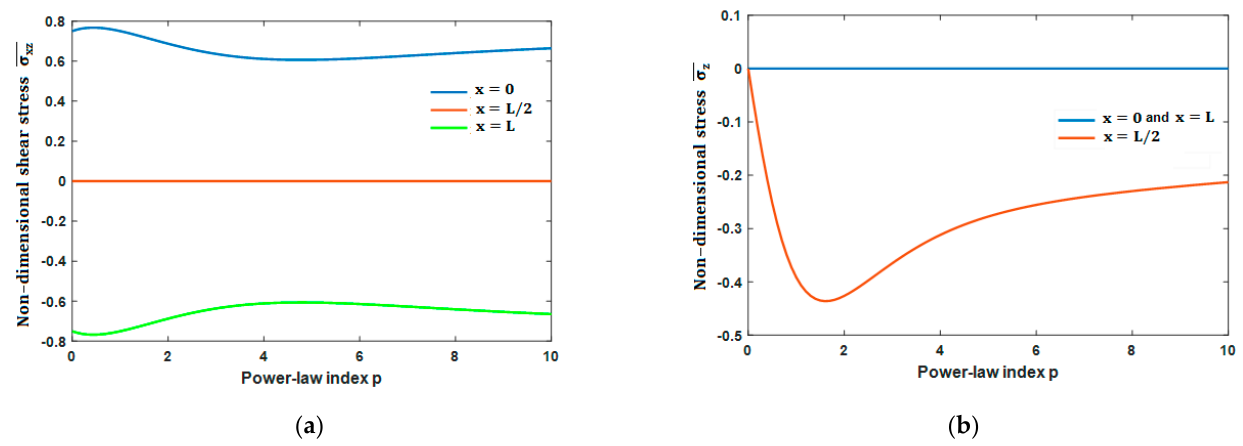
Figure 8. Non-dimensional: ( a ) Shear stress σ xz , ( b ) stress due to the thickness stretching σ z versus the material parameter. Variations of the non-dimensional axial stress σ x across the depth and versus non- dimensional length of the FGB are presented in Figure 9a,b for ( L / h = 5) and ( p = 5). The axial stress is zero at the end edges, but it is maximum at the middle of the beam, and the upper beam face is stretched. On the other hand, the lower face is compressed. Extension stress at the upper beam face is higher than the compressive stress at the lower face because at the upper face, the beam is ceramic-rich, whereas, at the lower face, it is metal-rich. It is observed that the neutral plan with zero axial stress is moved upwards relative to the middle position. This is due to the non-homogeneous material of the FG beam ( p = 5). Figure 10a,b plots the distributions of the non-dimensional shear stress σ xz through thethickness and versus the non-dimensional length of the FG beam, respectively, for ( L / h = 5) and ( p = 5). These figures reveal that the shear stress reaches its maximum value at the beam ends but with opposite signs. It is cancelled in the middle of the beam on the neutral plane and the lower and upper faces. As a result, the conditions of non-shearing on both the lower and upper faces of the beam are satisfied.